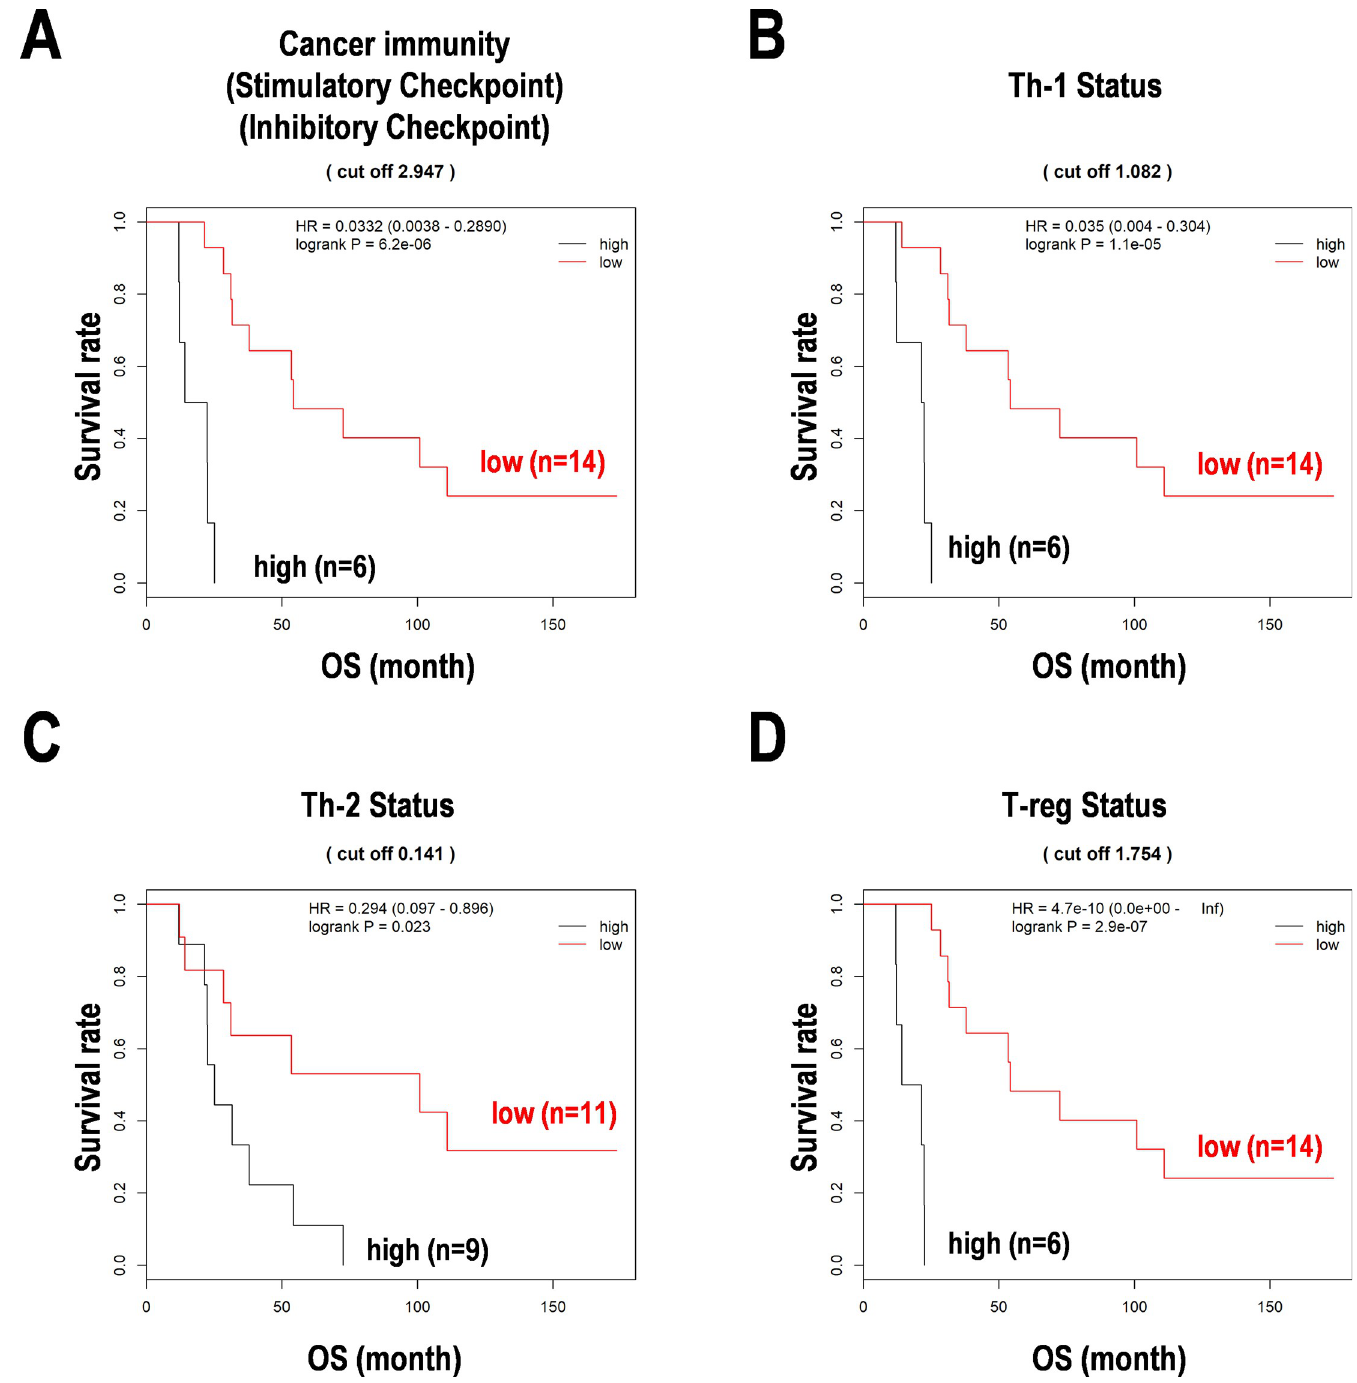
Fig 3. Survival distribution with the formulas based on the Cox regression analysis in PCNSL. ( A ) Cancer immunity and immune checkpoints (stimulatory and inhibitory checkpoints). ( B ) Th1 T-cell status. ( C ) Th2 T-cell status. ( D ) Regulatory T-cell (T-reg) status. The Kaplan-Meier curves are drawn by a cut off score calculated by each formula in PCNSL. OS, overall survival. HR, hazard